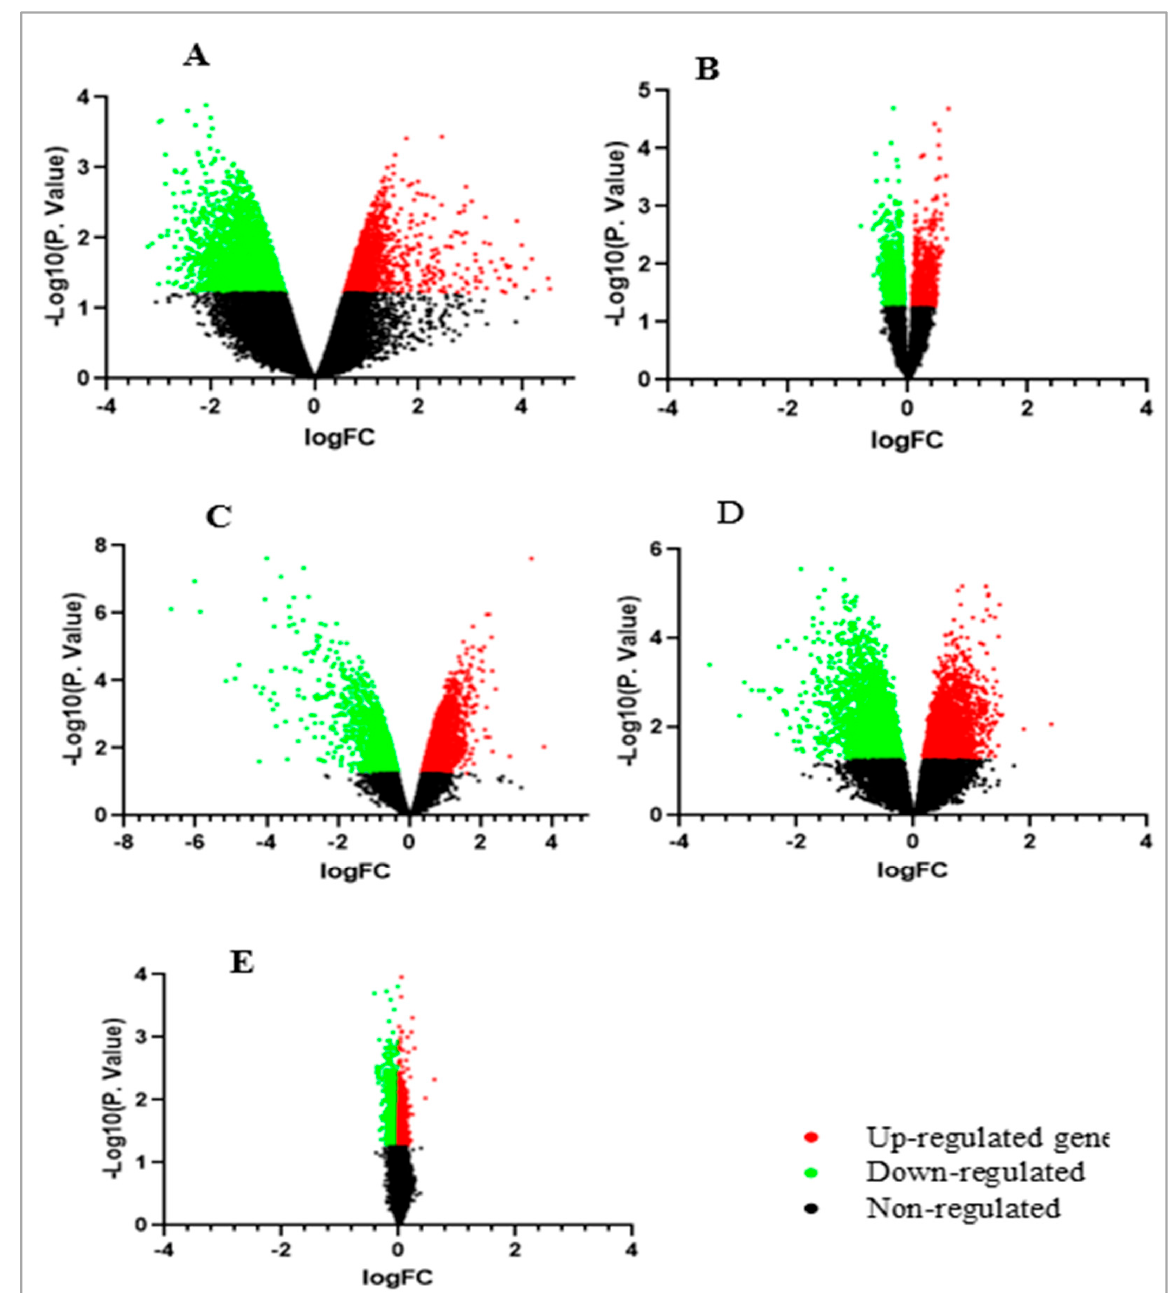
Figure 2. Volcano plot visualizing the differentially expressed genes in CHD microarray datasets: ( A ): GSE71226, ( B ): GSE12288, ( C ): GSE56885, ( D ): GSE42148 ( E ): GSE20681